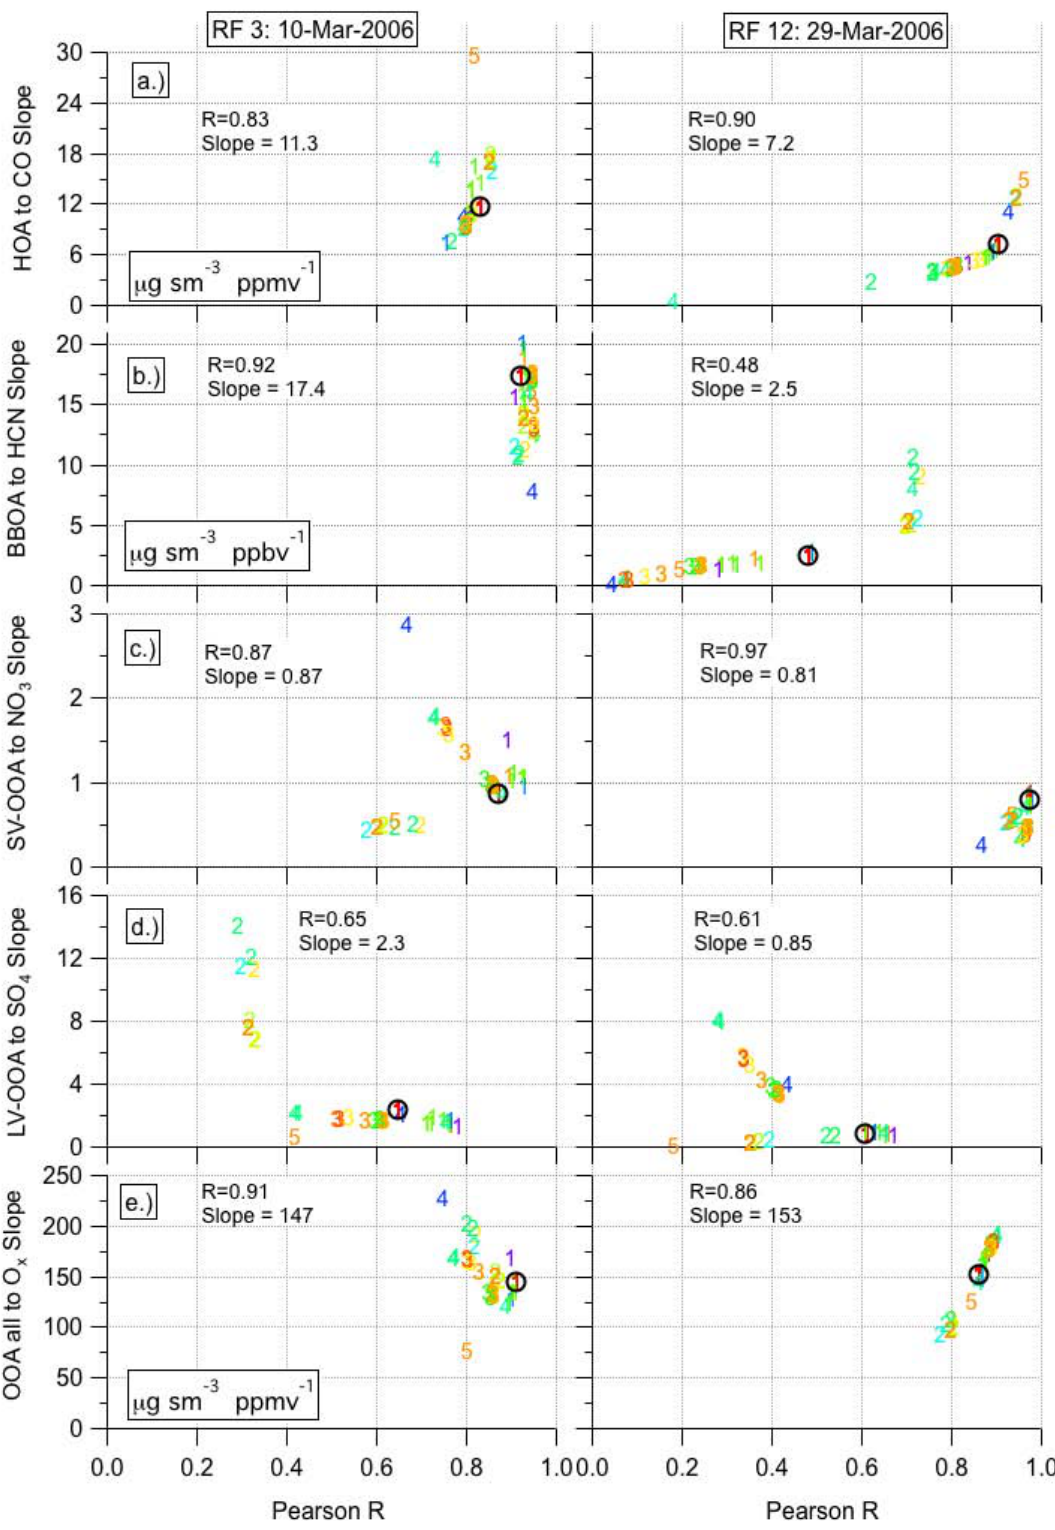
Fig. A2. The slope and Pearson R values from regressions of PMF factors vs. tracer species for the 50 seed solutions. The left column are the correlations for RF3 with the right column the same correlations for RF12. The Pearson R and slope of the chosen PMF solution is given in the caption and shown on the plot as the open black circle. Units when applicable are given in the row of the